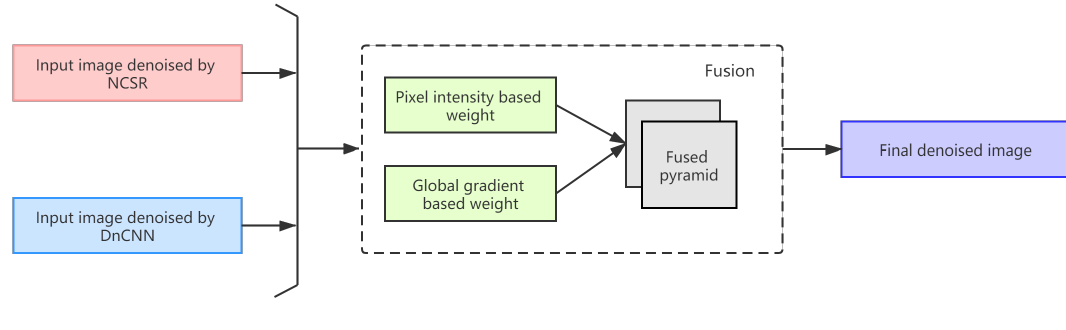
Figure 3. Overall framework of the proposed